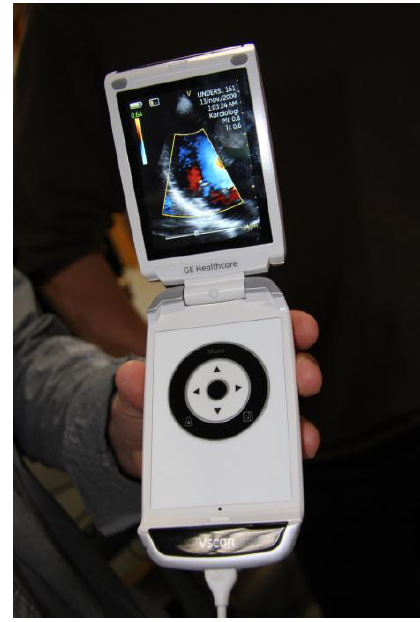
Figure 12: Vscan is a pocket-sized ultrasound machine from GE Vingmed Ultrasound in Horten. Photo: Camilla